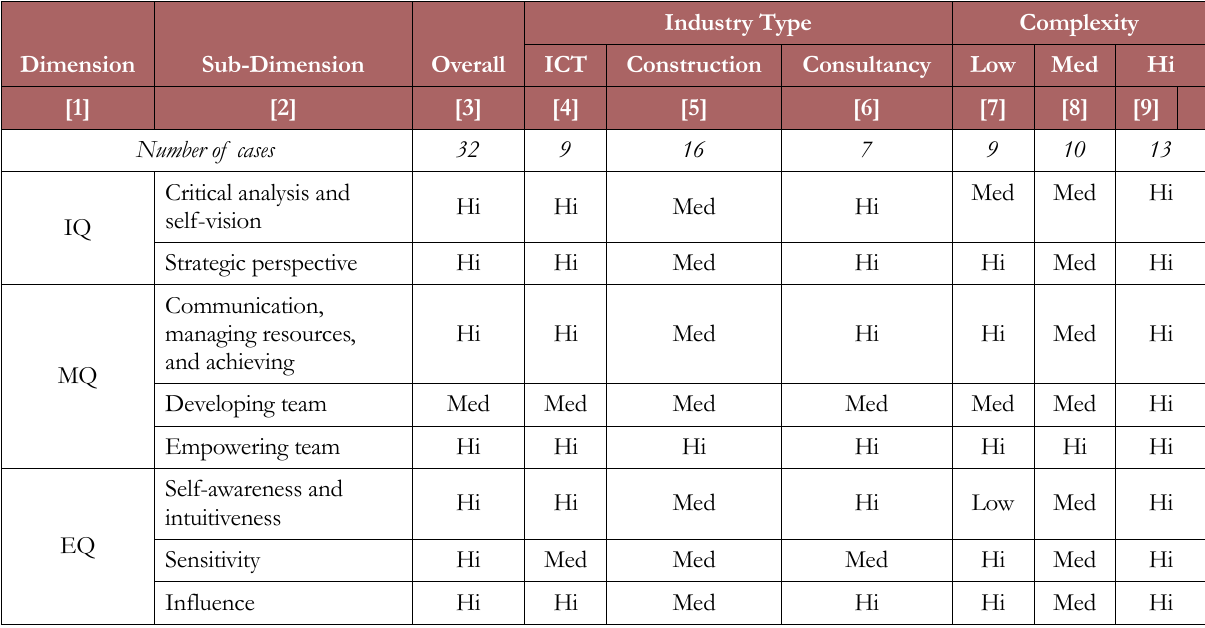
Table 5. Leadership Competency Map for More Successful Projects (Industry Type, Complexity as Moderating Variables)